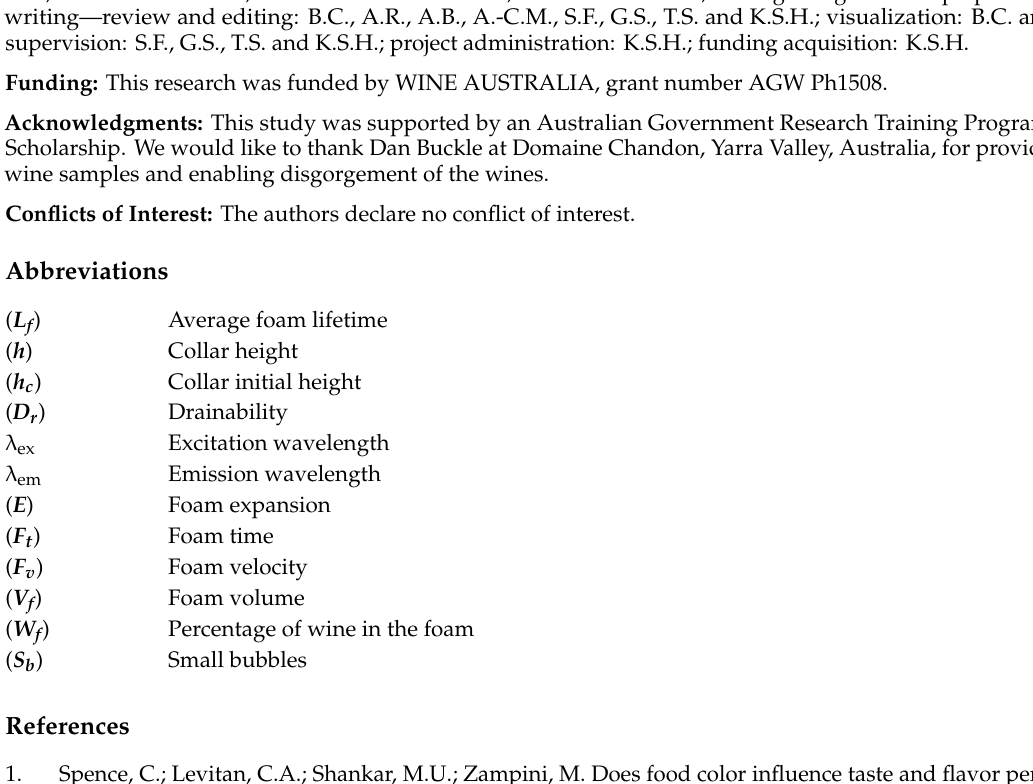
Table S1: Variable scores for each principal component related to three principal component analysis ( λ em 245 nm, λ em 350 nm, λ em 435